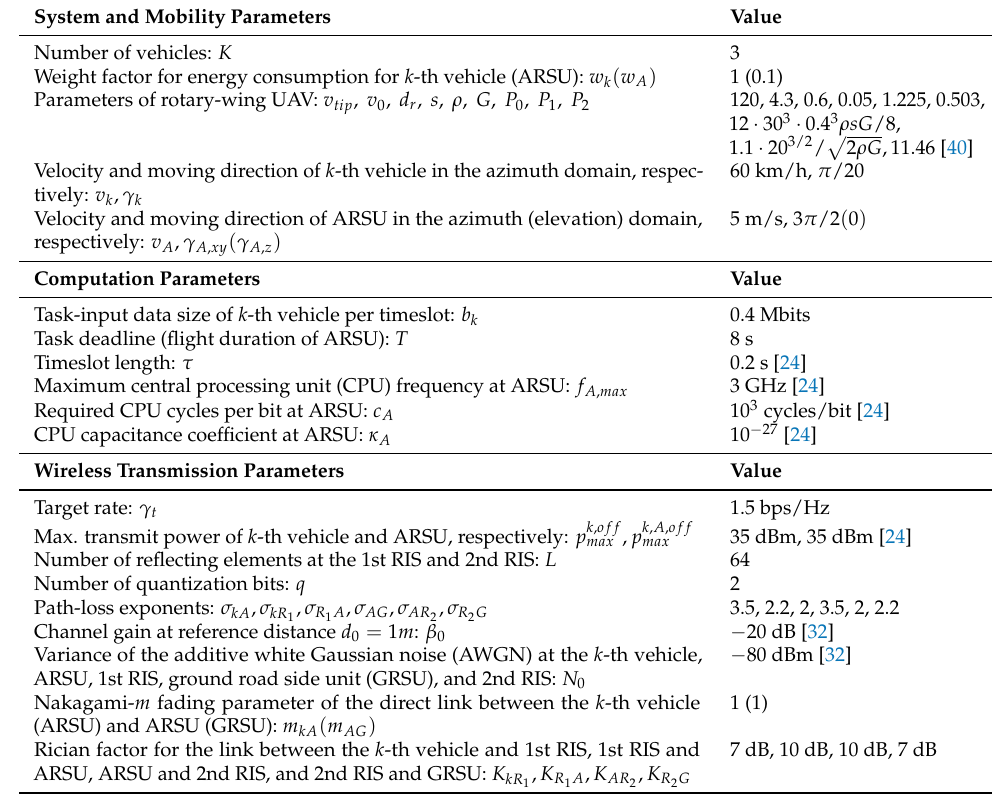
Table 2. Definition, Notation, and Value of Network